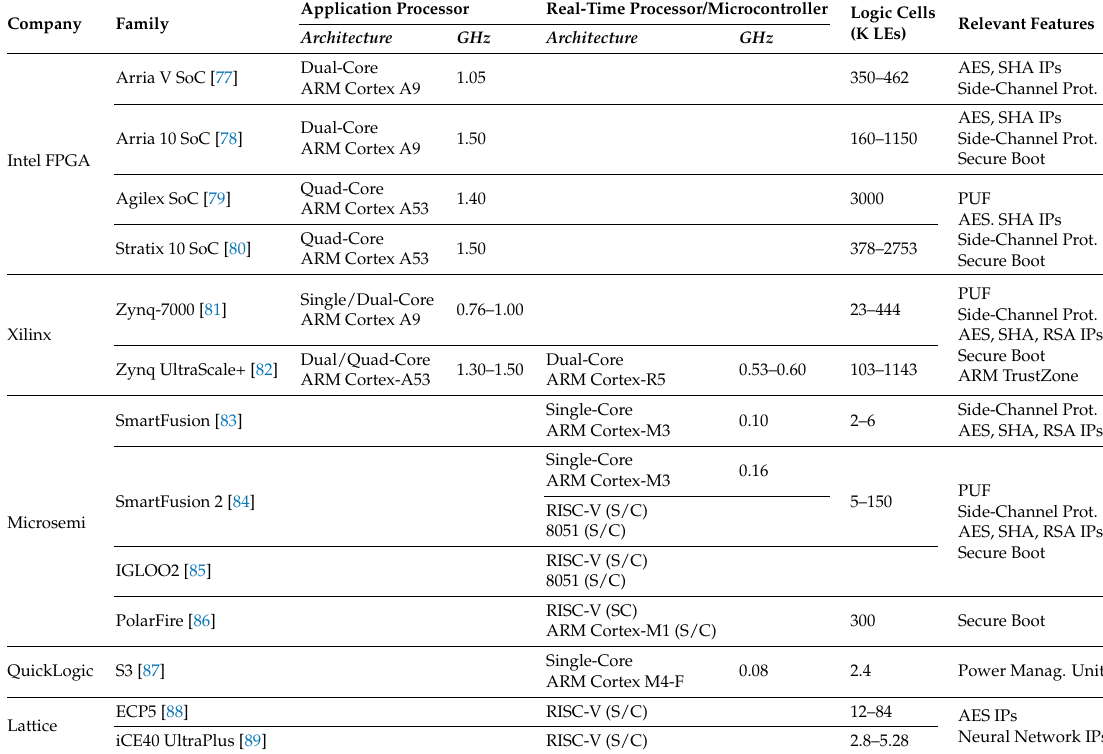
Relevant Features (K LEs)